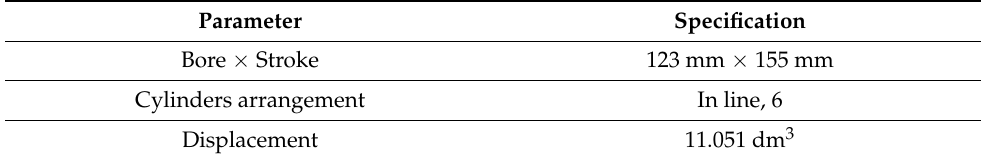
Table 4. Technical specifications of the Doosan MD196TI diesel engine